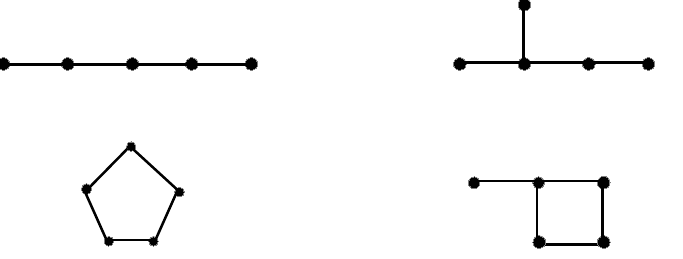
Figure 7. Isomers with five carbon atoms in the